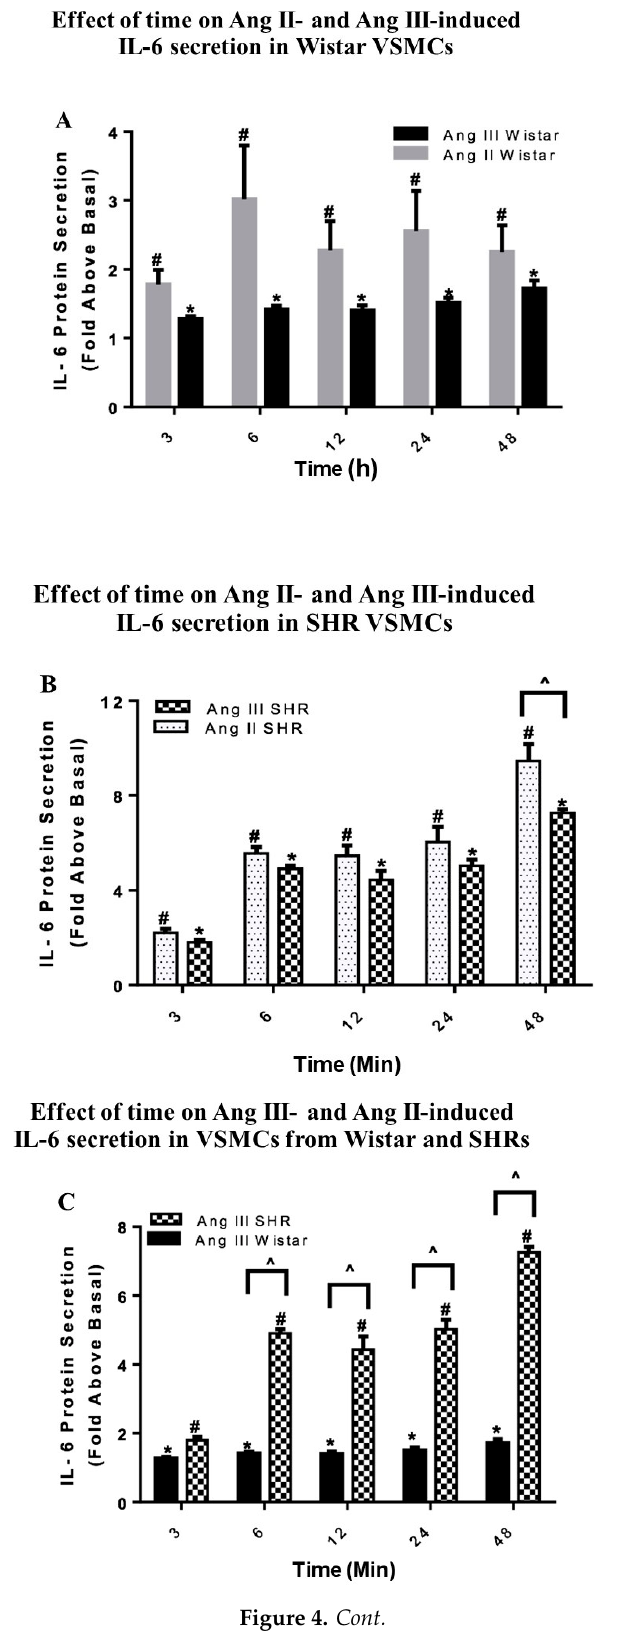
Figure 4. Effect of time on Ang II- and Ang III-induced IL-6 secretion in Wistar and SHR VSMCs. Quiescent VSMCs isolated from ( A ) Wistar rats treated with Ang II or Ang III, and ( B ) SHRs treated with Ang II or Ang III were treated with 100 nM Ang II or 100 nM Ang III for 3 h to 48 h. Panel ( C ) compares Ang III-mediated IL-6 secretion from Wistar and SHR VSMCS. Panel ( D ) compares Ang II- mediated IL-6 secretion from Wistar and SHR VSMCs. Secreted levels of IL-6, induced by Ang II and Ang III, were calculated as the fold above basal and were analyzed by an ELISA method. Each value represents the mean ± SEM of preparations of VSMCs isolated from four or more SHRs or Wistar rats. * Denotes p < 0.05 as compared to basal levels of IL-6 secretion in VSMCs treated with Ang III. # Denotes p < 0.05 as compared to basal levels of IL-6 secretion in VSMCs treated with Ang II. ^ Denotes p < 0.05 as compared between the effects of Ang II or Ang III in stimulation of IL-6 secretion in VSMCs isolated from SHRs versus Wistar rats. 2.6. Effects of AG490, Losartan and PD123319 on Ang III-induced IL-6 Secretion Quiescent VSMCs were pretreated with 50 µM AG490 (the JAK2 inhibitor) or 10 µM Losartan (AT 1 R antagonist) or 10 µM PD123319 (AT 2 R antagonist) followed by 100 nM Ang III for 3 h. Then, ELISA was employed to measure the secreted levels of IL-6. Pretreatment with AG490 completely abolished Ang III-induced IL-6 secretion (Figure 5A). Further Losartan completely blocked Ang III-